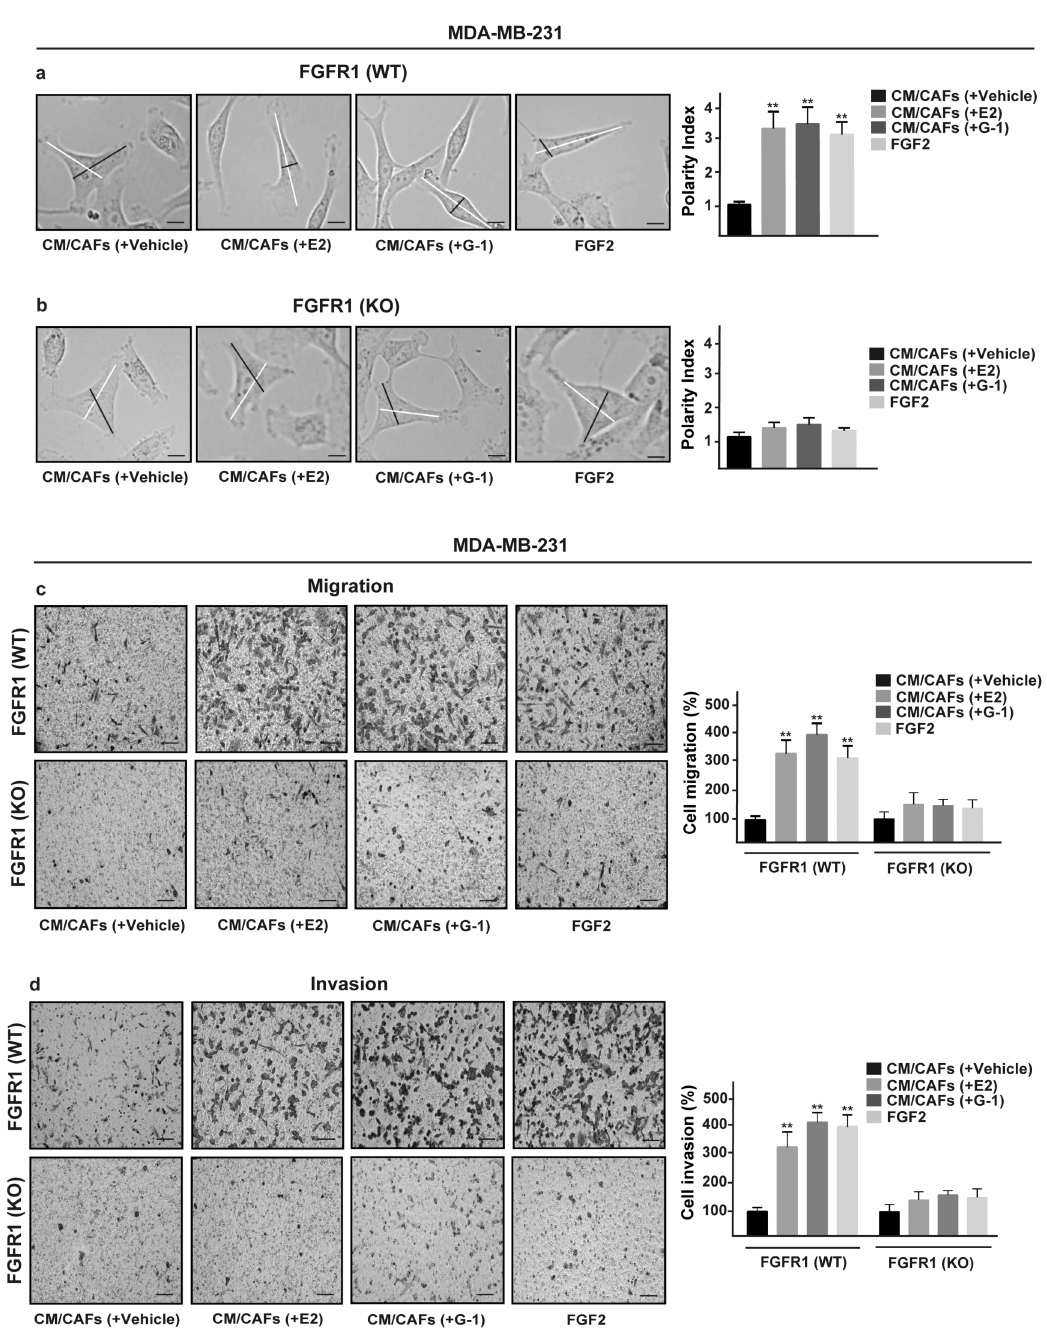
Figure 7. FGFR1 paracrine activation promotes migration and invasion in MDA-MB-231 cells. ( a ) FGFR1 (WT) and (b ) FGFR1 (KO) MDA-MB-231 cells were cultured for 8 h in CM from CAFs treated for 18 h with vehicle [CM/CAFs (+vehicle)], 10 nM E2 [CM/CAFs (+E2)] or 100 nM G-1 [CM/CAFs (+G-1)], or exposed to 25 nM FGF2, as positive control. Lines traced on cells were used to calculate the Polarity Index (PI). White lines define the migratory axis and black lines the transversal axis. PI = 1.0 indicates a polygonal shape, whereas a value > 1.0 defines ranges of migratory shapes. Scale bar = 30 µ m. Images shown are representative of 30 random fields acquired in three independent experiments. Transwell assays were used to assess cell migration ( c ) and invasion ( d ) in FGFR1 (WT) and FGFR1 (KO) MDA-MB-231 cells cultured for 8 h in CM from CAFs treated for 18 h with vehicle [CM/CAFs (+vehicle)], 10 nM E2 [CM/CAFs (+E2)] or 100 nM G-1 [CM/CAFs (+G-1)], or exposed to 25 nM FGF2, as positive control. Cells were counted in at least 10 random fields at 10 × magnification, in three independent experiments performed in triplicate. Scale bar = 200 µ m, (**) indicates p <